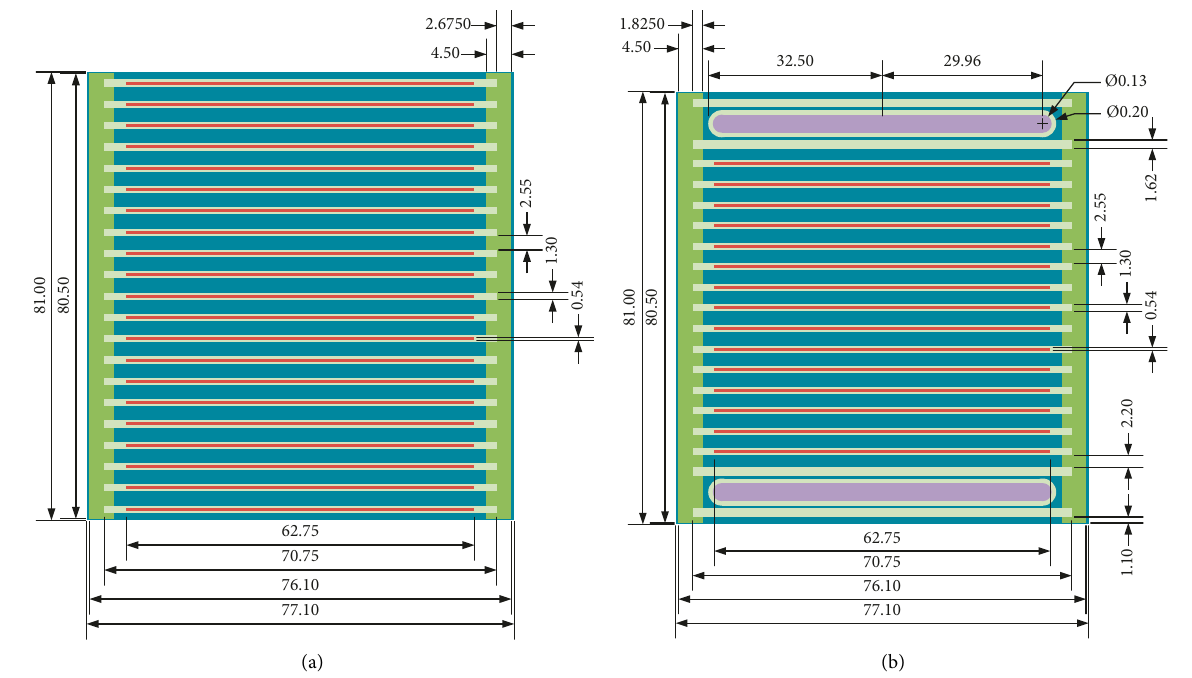
Figure 1: Standard fuel element (a) and control element (b) layout